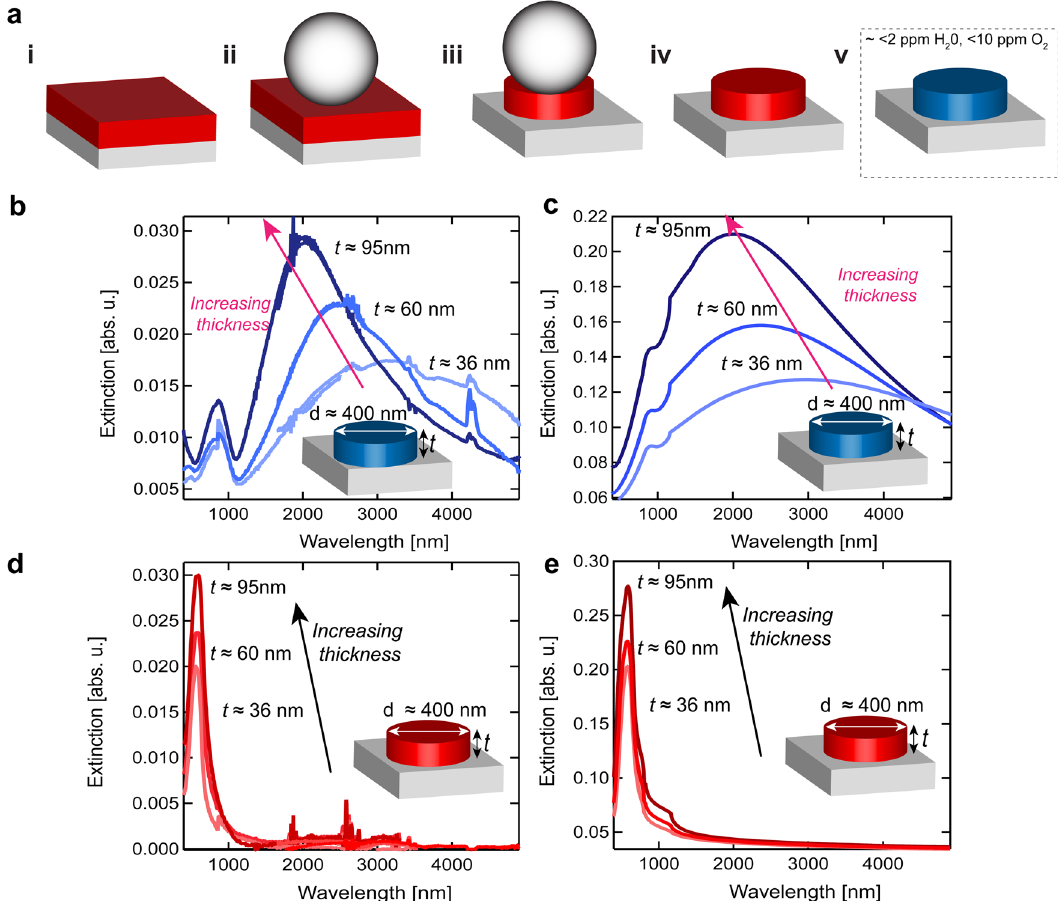
Fig. 2 Resonance-tuning by nanodisk geometry. a Schematic of the fabrication process of PBTTT nanodisk arrays based on a modi fi ed version of colloidal lithography. b Experimental and c simulated extinction spectra of undoped PBTTT nanodisks made with dimensions (diameter ≈ 400 nm, thicknesses ≈ 36 nm, 60 nm, 95 nm) extracted from AFM height and width analyses (Supplementary Figs. 7 – 9b, c). d Experimental and e simulated extinction spectra of doped PBTTT nanodisks made with dimensions (diameters ≈ 400 nm, thicknesses ≈ 36 nm, 60 nm, 95 nm, period = 800nm, mesh size = 2 × 2 × 2 nm 3 around the nanodisks) extracted from AFM height and width analyses (Supplementary Figs. 7 – 9b, c).